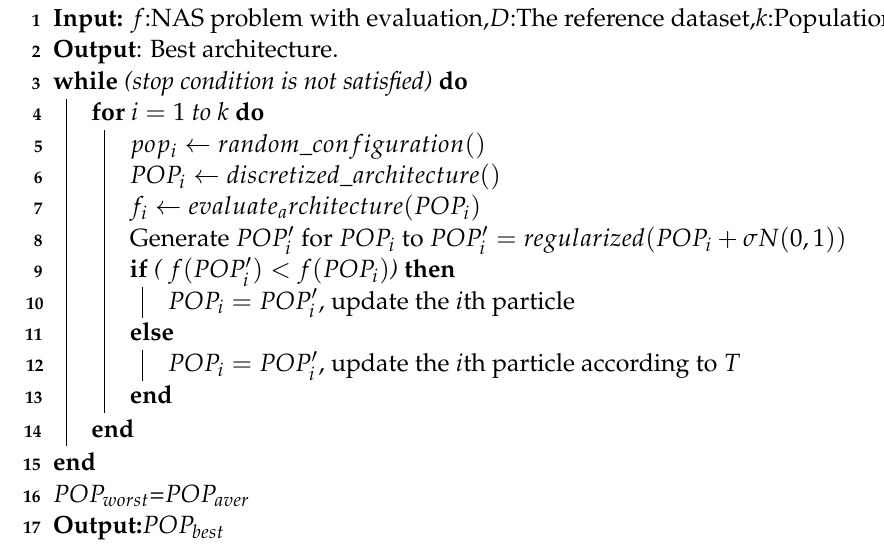
Algorithm 2: Pseudocode of